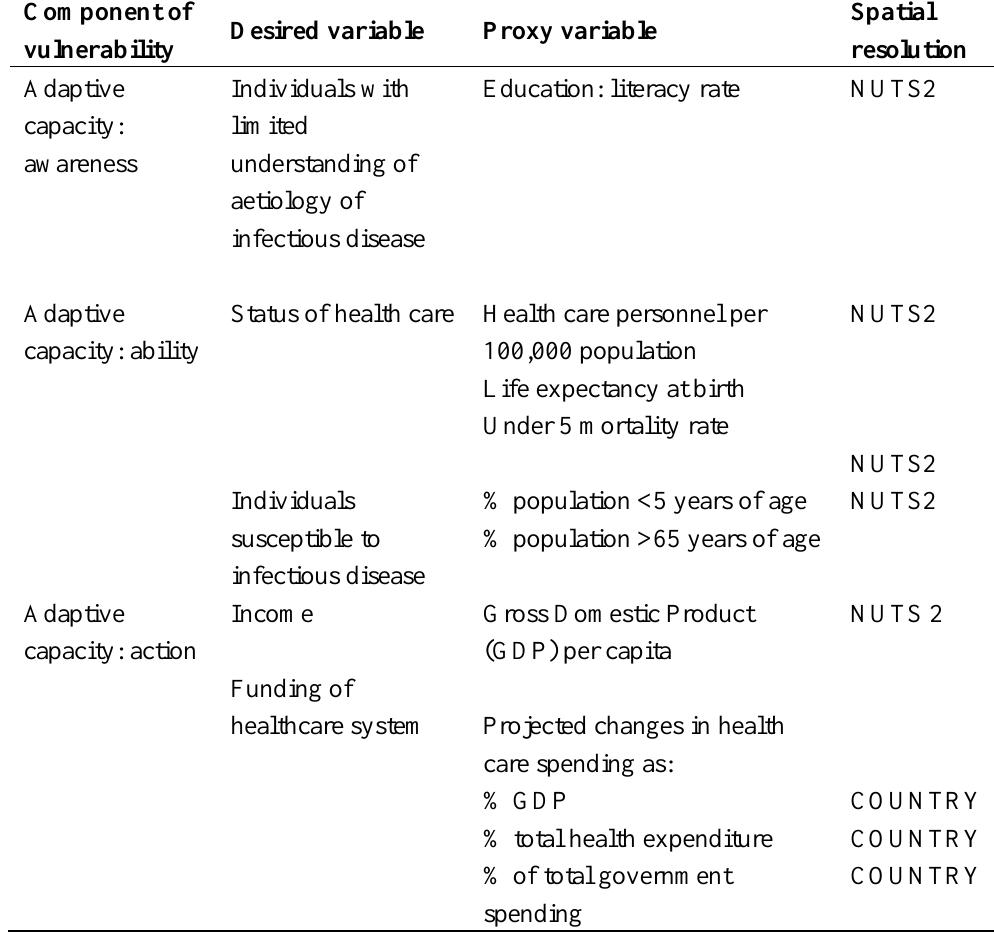
Table 1. Sample datasets for consideration as components of adaptive